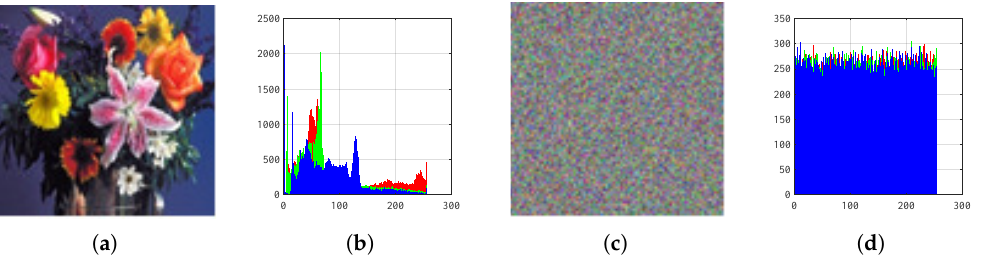
Figure 11. Histograms: ( a ) Flowers image, ( b ) histogram of plain Flowers, ( c ) encrypted Flowers, and ( d ) histogram of encrypted Flowers.